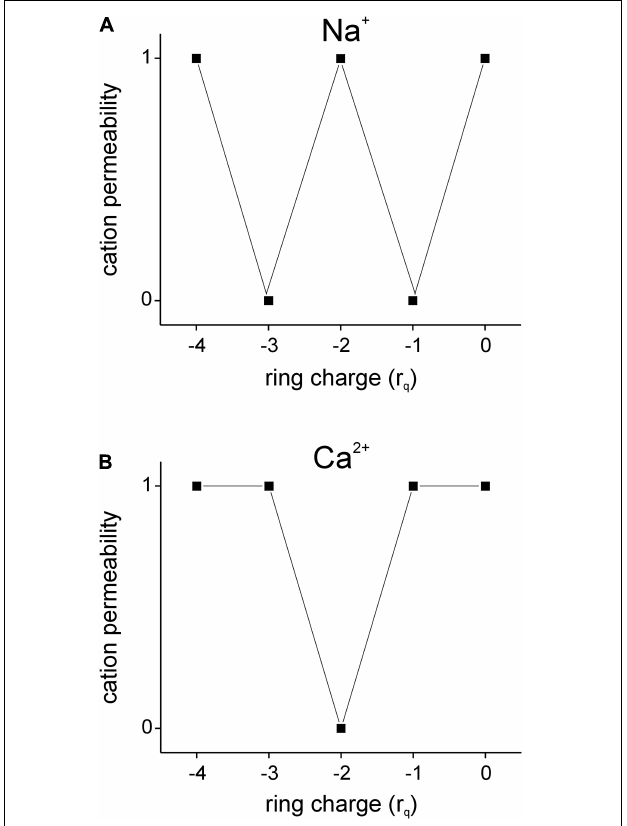
FIGURE 6 | Permeability plots for monovalent (Na + , A ) and divalent (Ca 2 + , B ) cations as a function of total ring charge ( r q ) are distinct from one another within the range –4 ≤ r q ≤ 0 as predicted by the charge permeability equation (1 = permeable ; 0 = not permeable ). Note that only when r q = –4 or 0 are AMPA and NMDA receptor channels fully permeable to both Na + and Ca 2 + , but otherwise (–3 ≤ r q ≤ –1) are rendered selective for one cation over the